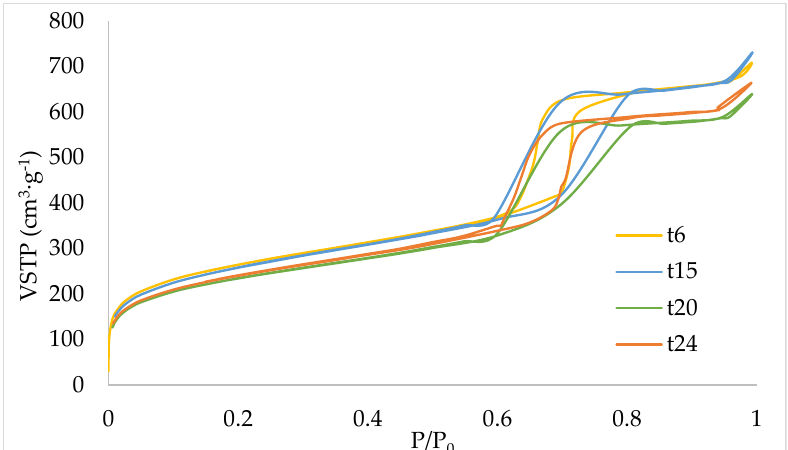
Figure 4. N 2 adsorption isotherms corresponding to the samples for time study.